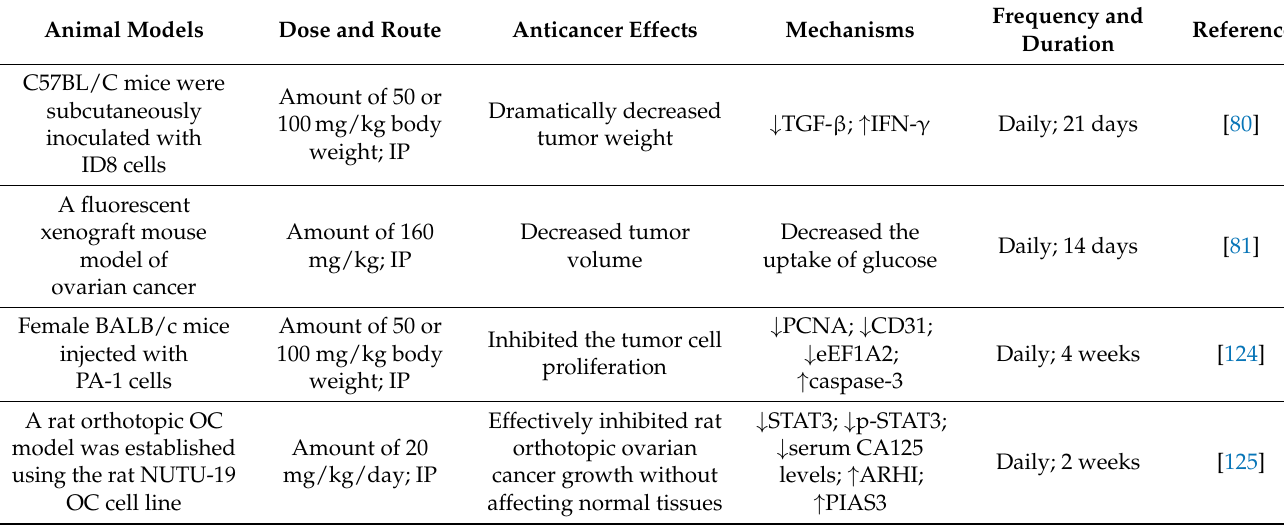
Table 3. Effect of resveratrol in xenograft models of ovarian